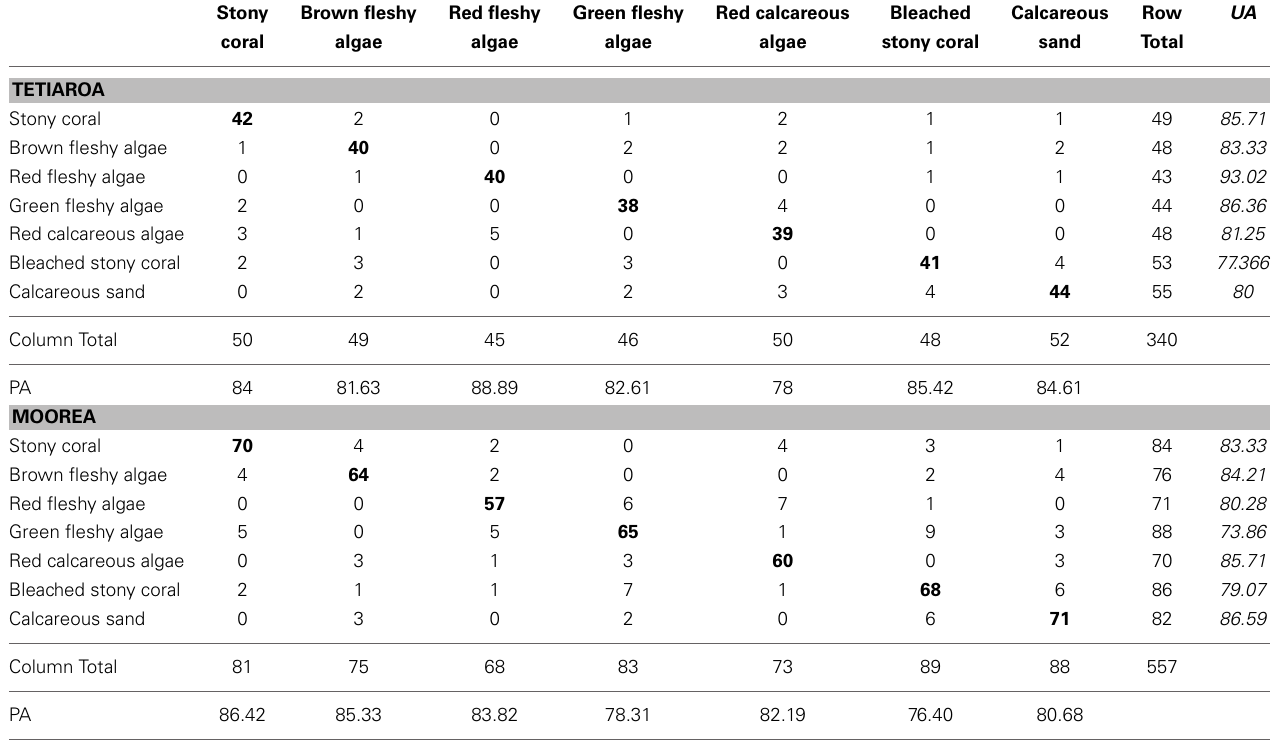
Table 2 | Contingency matrices depicting Tetiaroa ( n = 340) and Moorea ( n = 557) field-observed coral reef habitats vs. their classification based on the seven-habitat slicing of the spatial model built from the Normalized Difference Ratio combining the “red edge” and the green WorldView-2